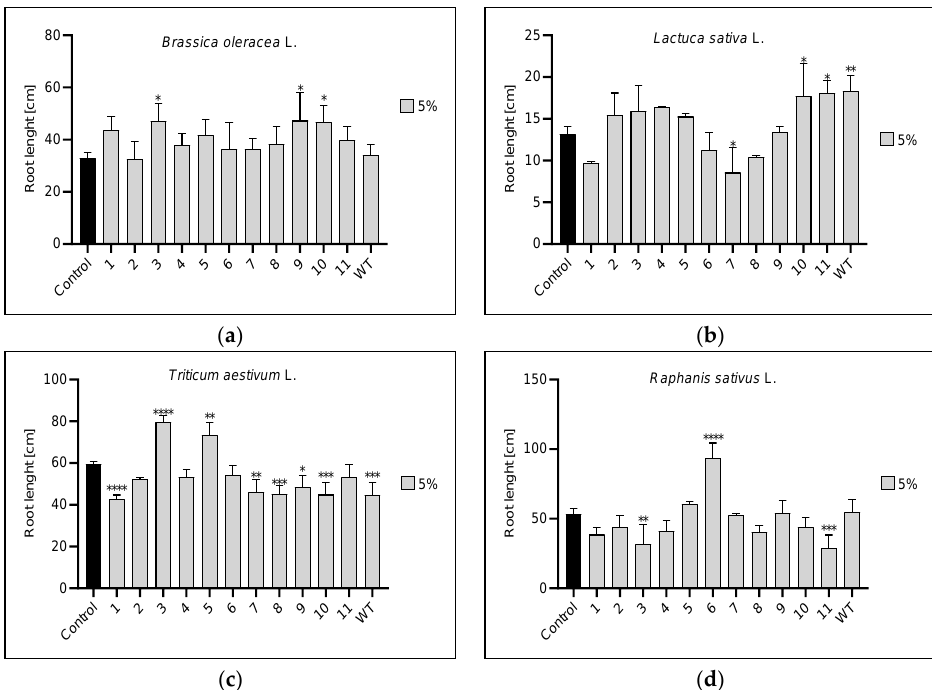
Figure 6. Root length of broccoli ( a ), lettuce ( b ), wheat ( c ), and radish ( d ) sprouts treated with 5% concentration for all algae clones tested (1-11, WT) and control (Control). Values represent mean ± SD, n = 10 plants, * p < 0.1, ** p < 0.01, *** p < 0.001, **** p < 0.0001 compared to control (ANOVA and Dunnett’s a posteriori test).